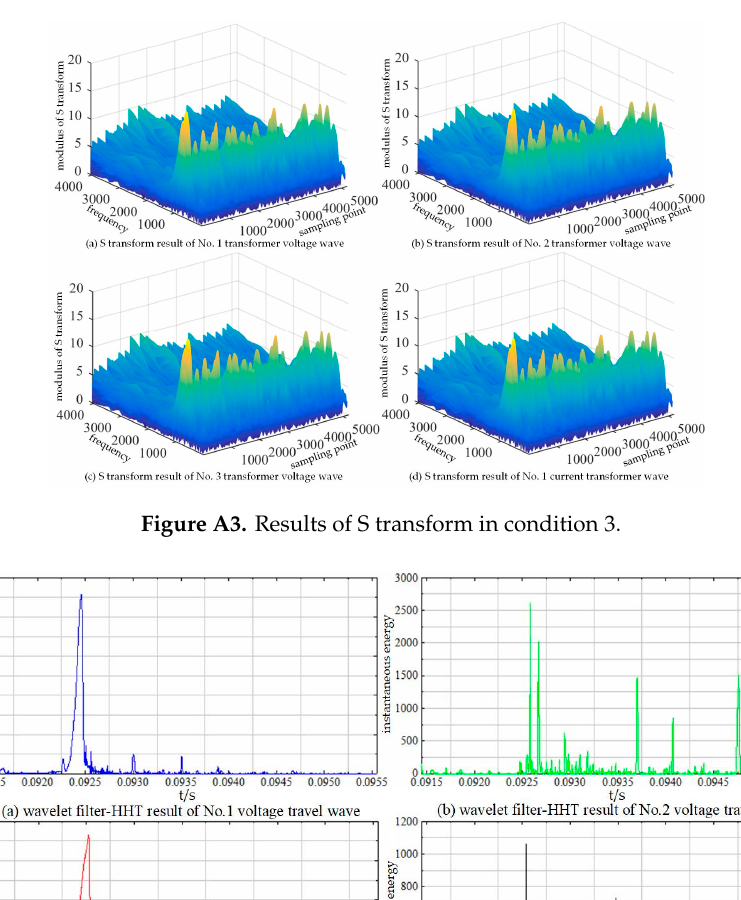
Figure A2. Results of S transform in condition 2.